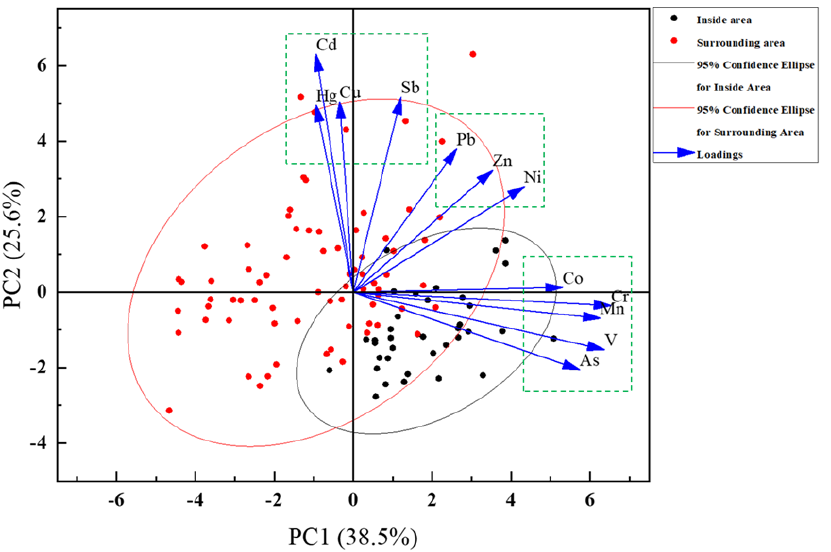
Figure 3. Principal component analysis of the HMs inside and around the petrochemical complex.